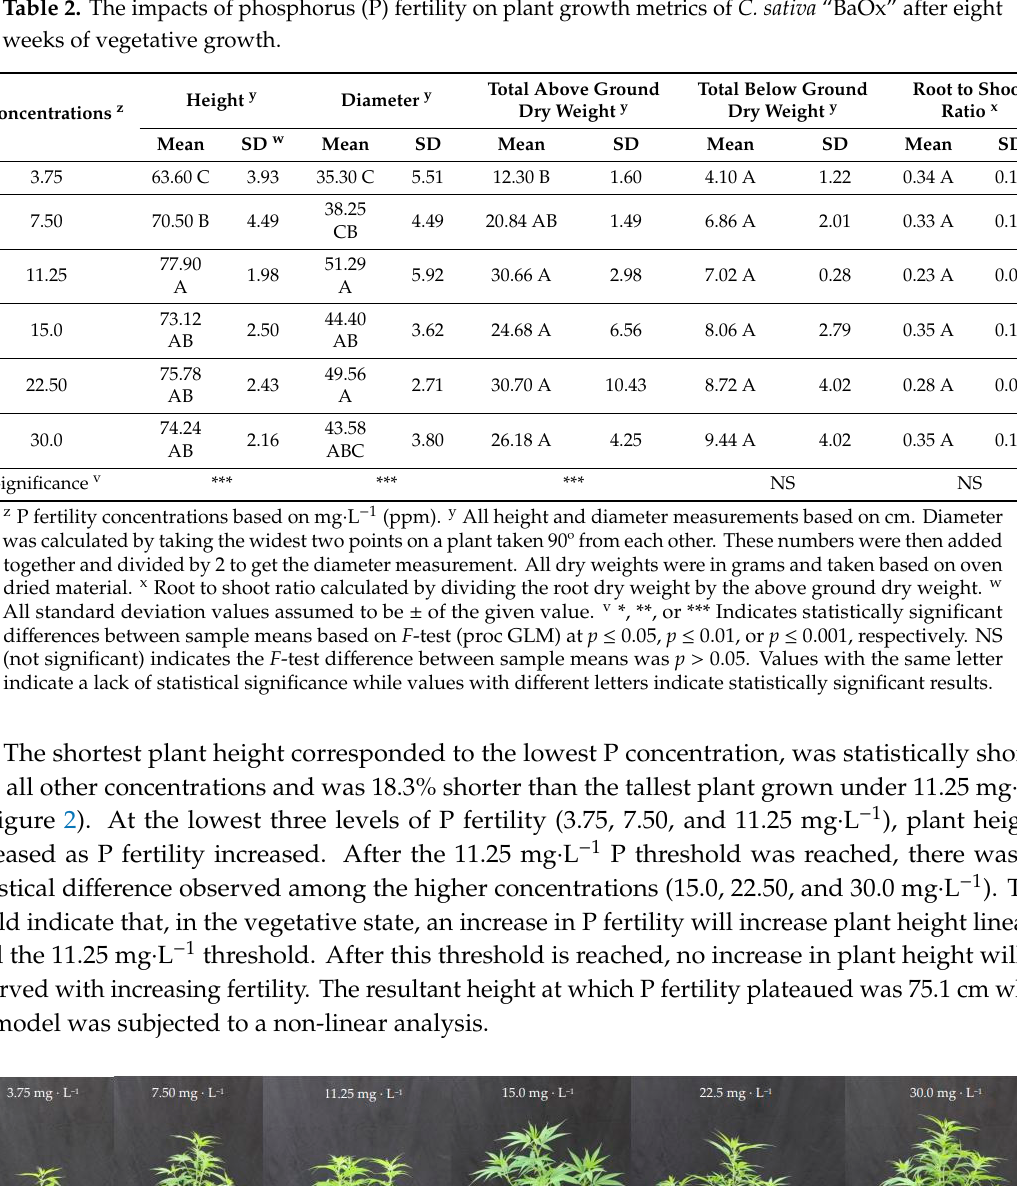
Table 2. The impacts of phosphorus (P) fertility on plant growth metrics of C. sativa “BaOx” after eight weeks of vegetative growth. P Concentrations z